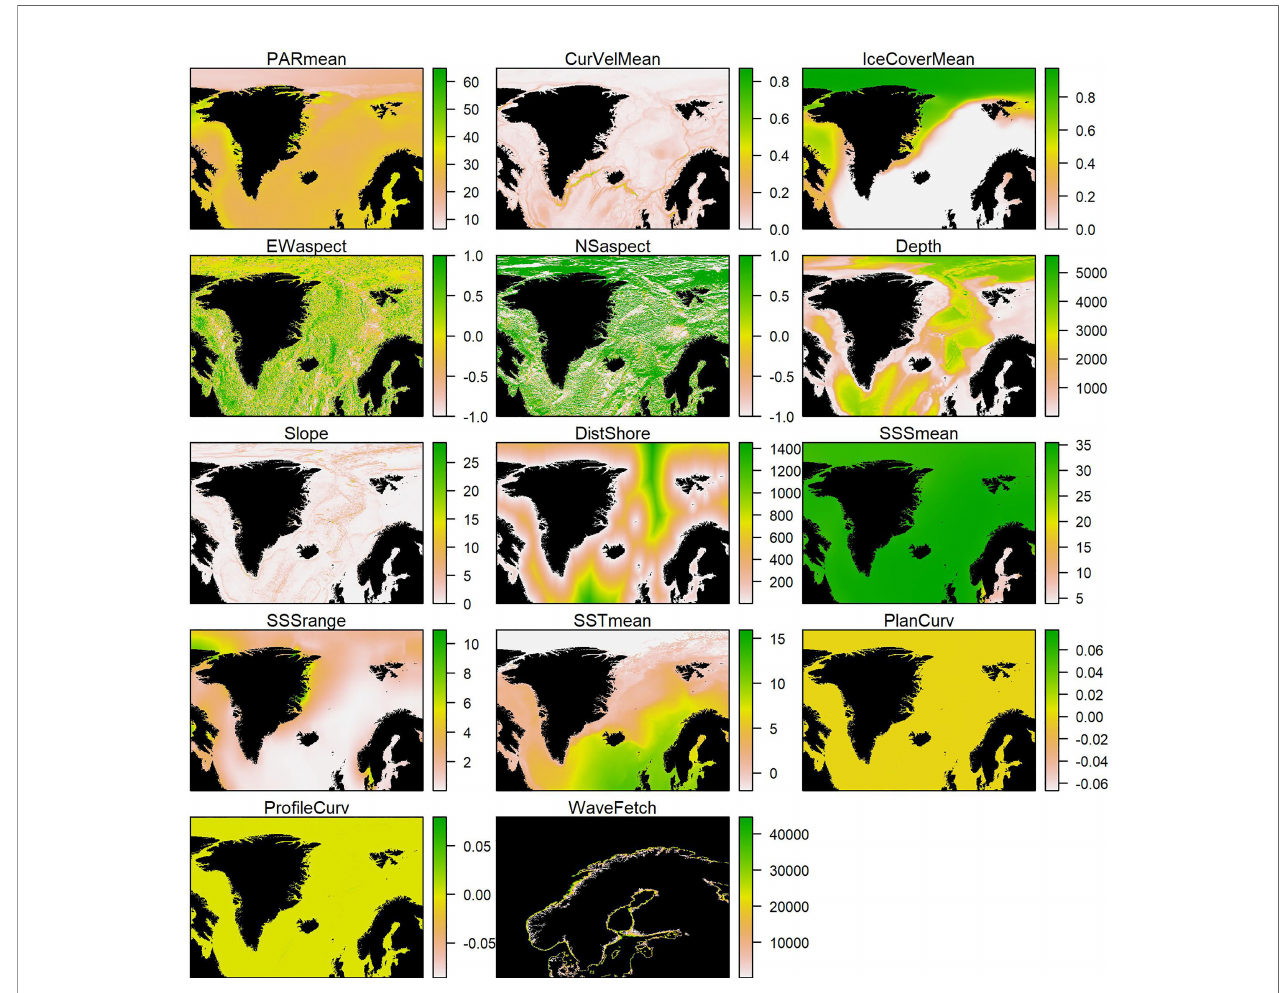
FIGURE 2 | All environmental GIS-layers used in model fi tting and predictions. Areas with missing values (including land) are shown in black. For wave fetch, the map is zoomed in to the extent of the GIS